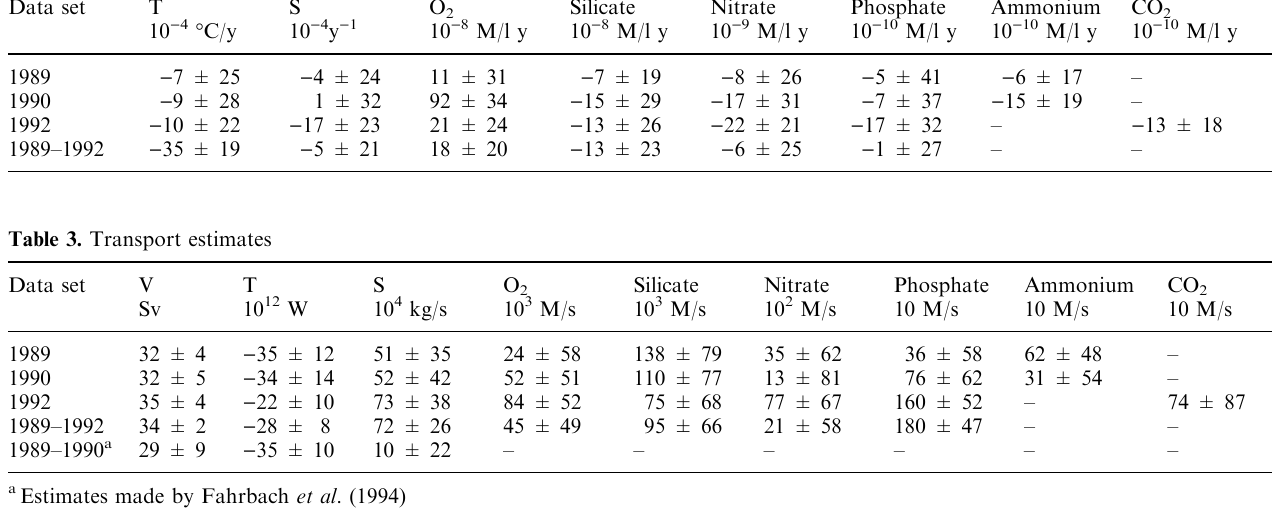
Table 2. Tracer sources (cid:22) F n Data set Silicate Nitrate